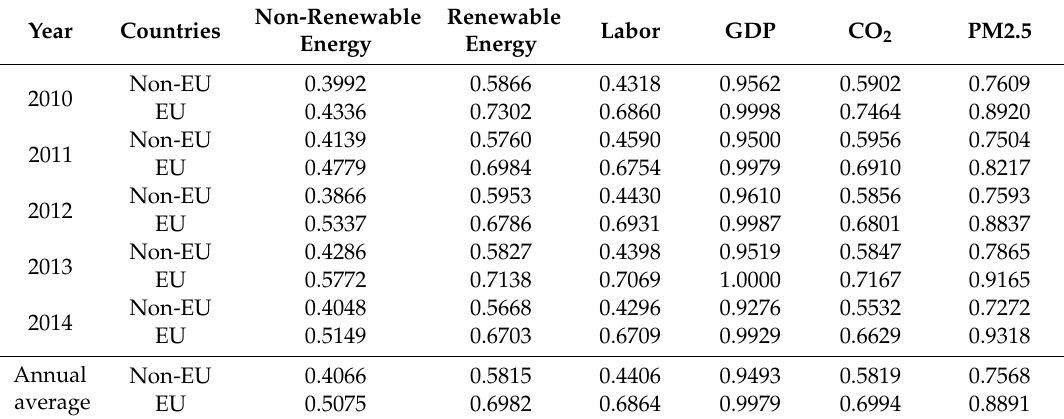
Table 9. Comparison of energy e ffi ciencies during 2010 to